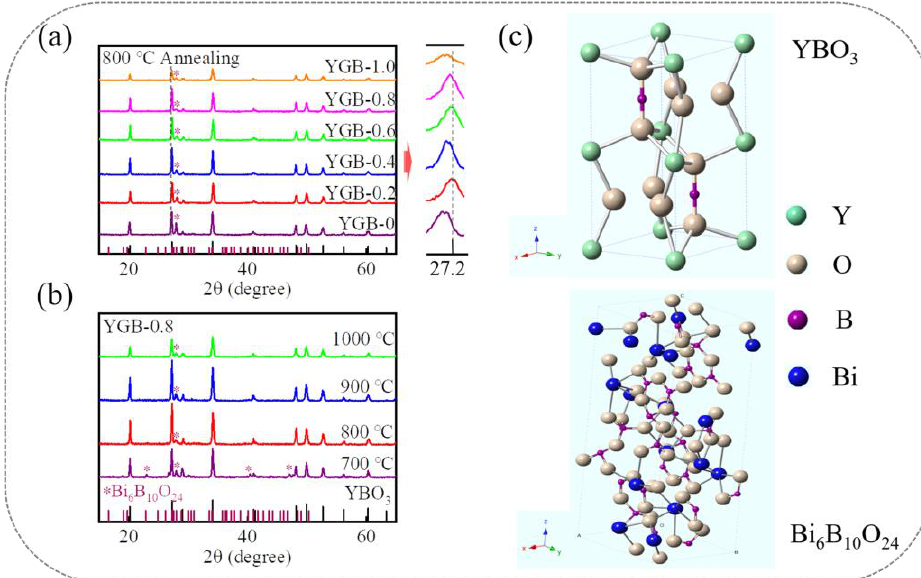
Figure 3. XRD patterns of ( a ) Y 0.9 (Gd x Bi 1 − x ) 0.1 BO 3 (x = 0, 0.2, 0.4, 0.6, 0.8 and 1.0) phosphors annealed at 800 °C and ( b ) YGB-0.8 phosphors with different annealing temperatures ranging from 700 °C to 1000 °C. The ⁎ represents the diffraction peaks from Bi 6 B 10 O 24 phase. ( c ) The crystal structure of YGB systems, showing the coordination environment of YBO 3 and Bi 6 B 10 O 24 .